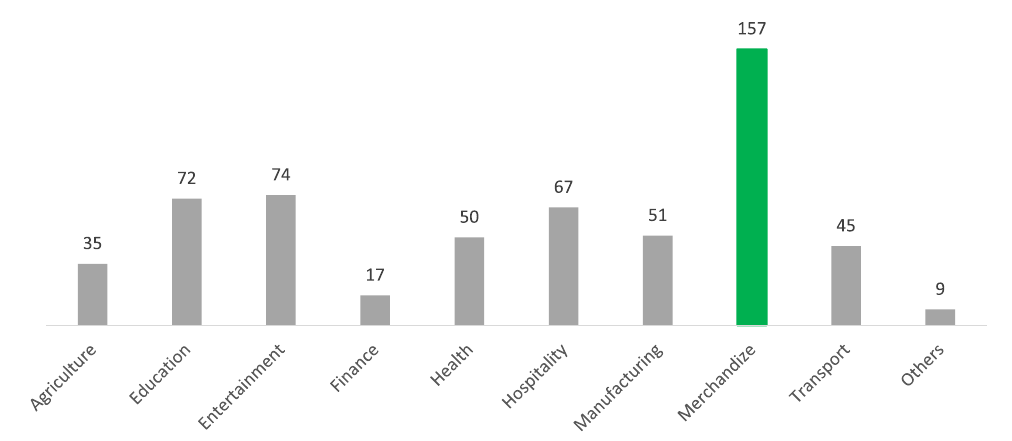
Fig. 1 Number of Participating SMEs in each Sector. Source: Researchers’